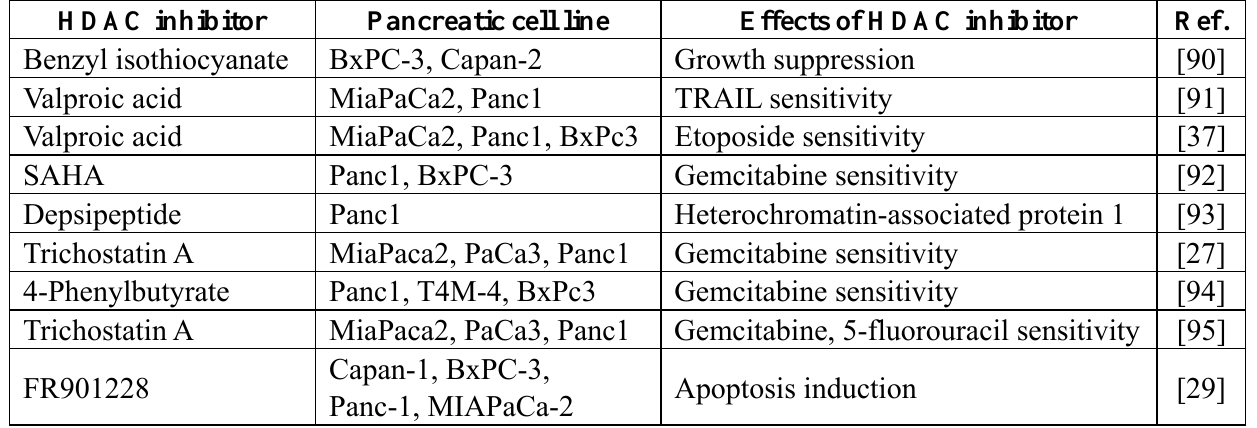
Table 4. Effects of HDAC inhibitors in pancreatic cancer